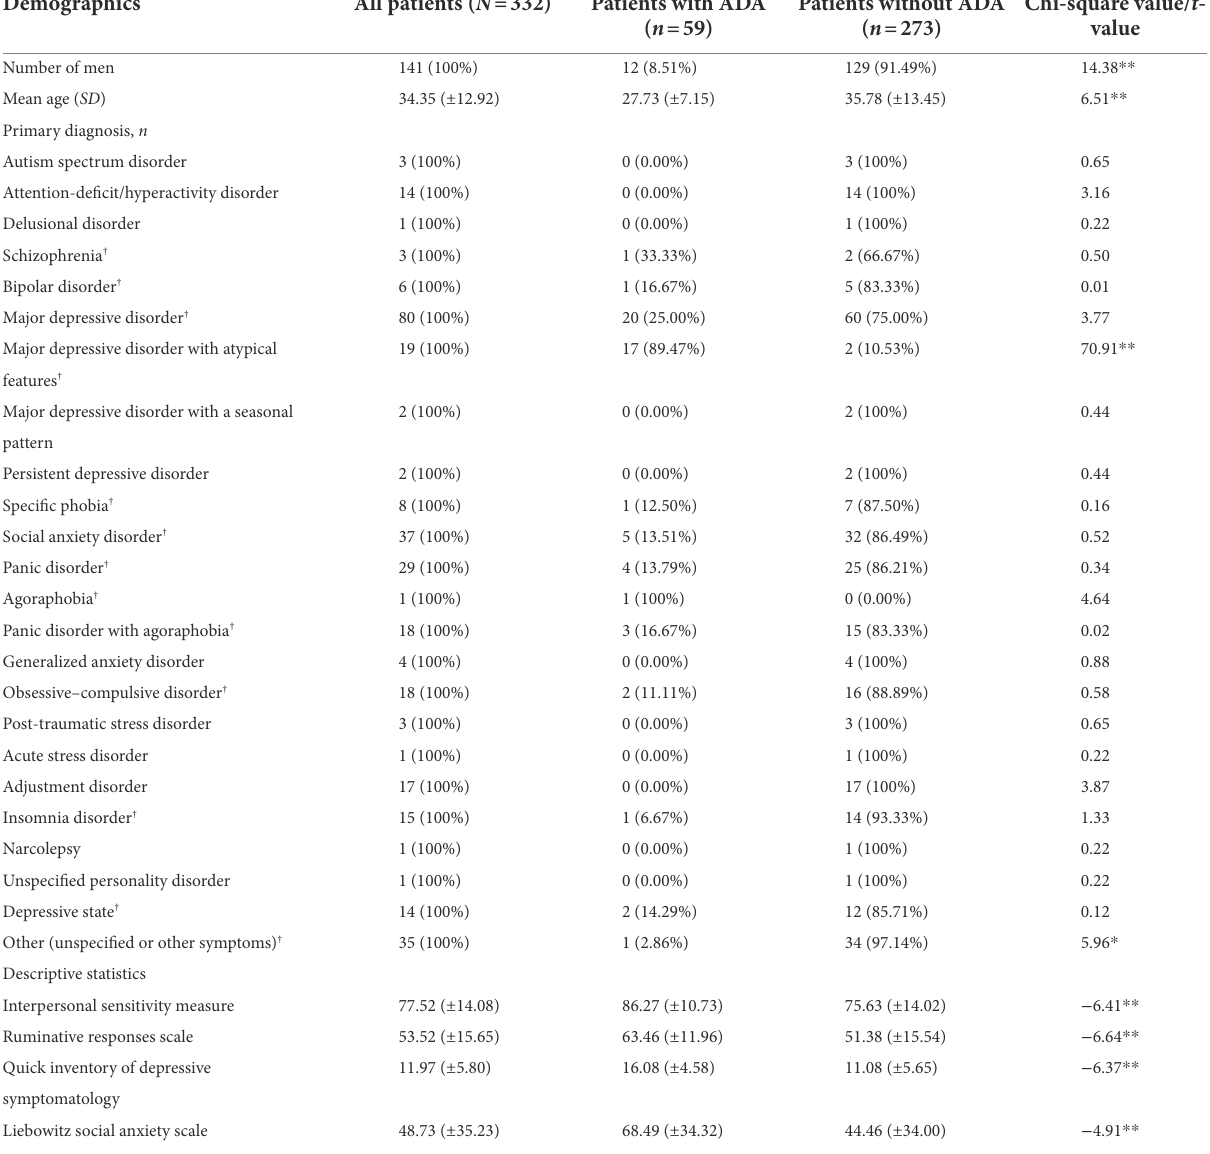
TABLE 2 Clinical characteristics of